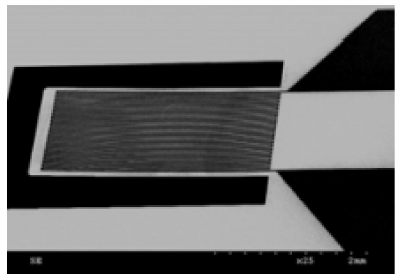
Figure 5. Si microcantilever structure with TiNi electrodes. Reproduced with permission from Ref.